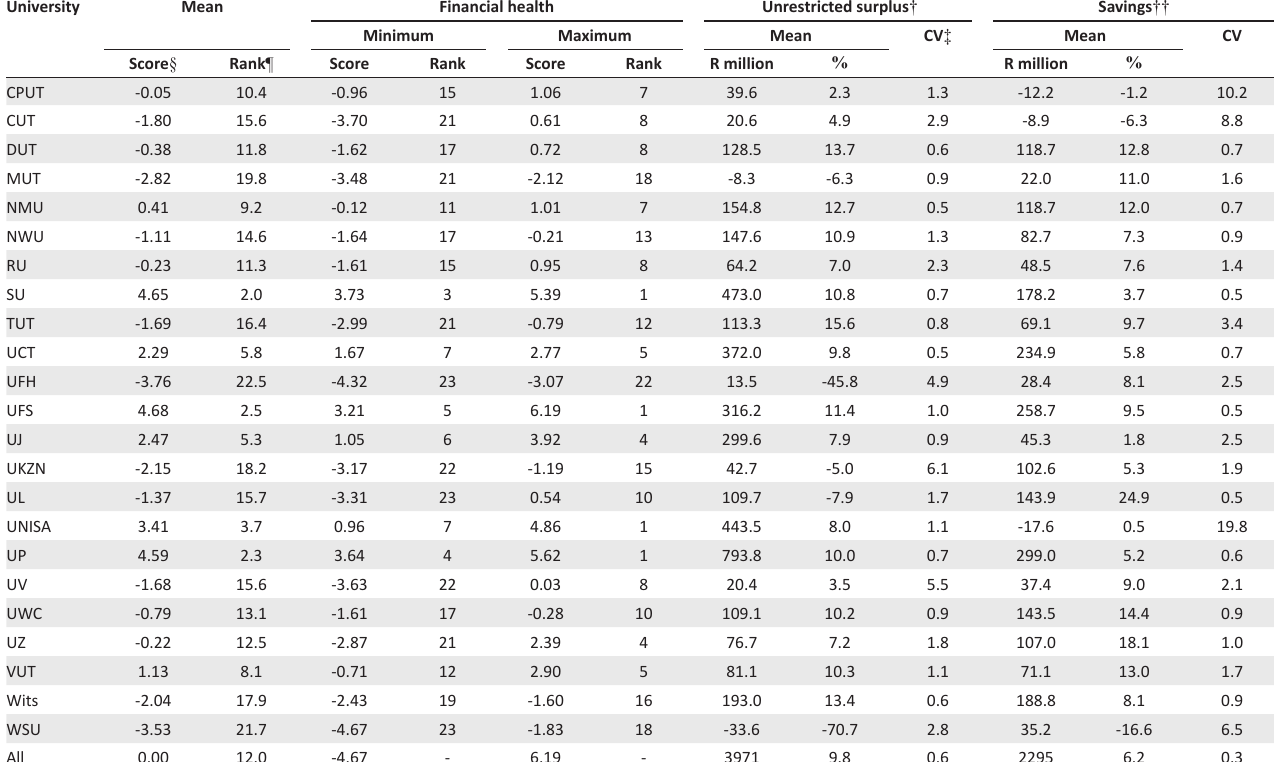
TABLE 7: Selected financial data by institution, 2007–2016.